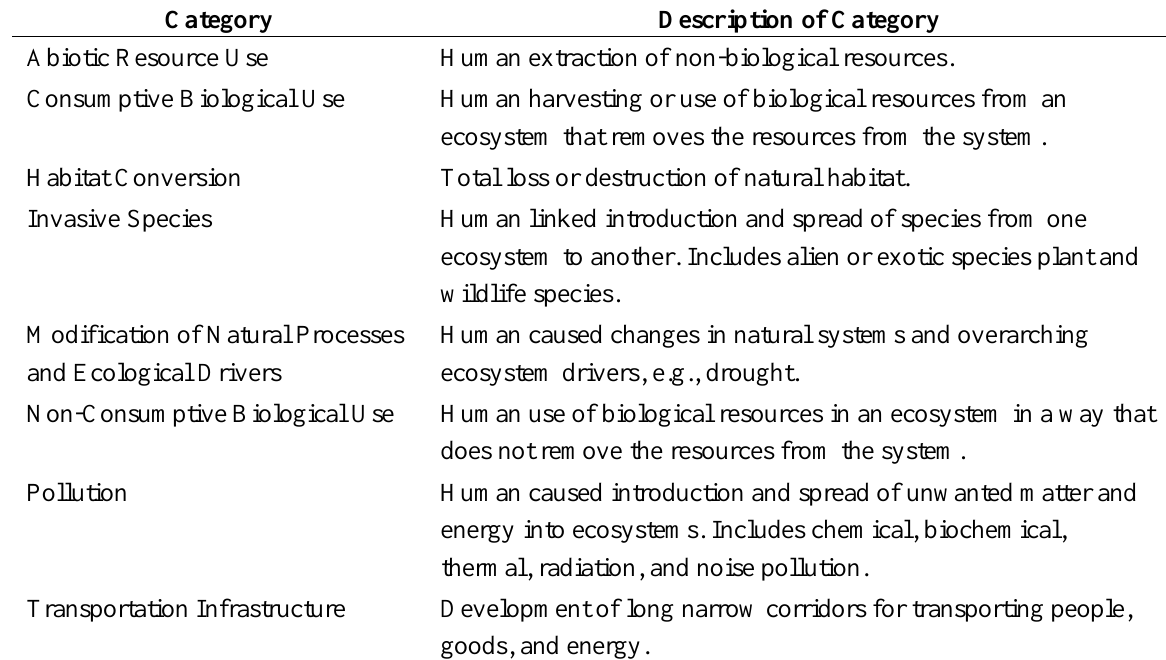
Table 3. Description of categories of factors that influence habitats used in the CWCS for New Mexico. Descriptions derived from Salafsky et al. [16] and TNC [17].